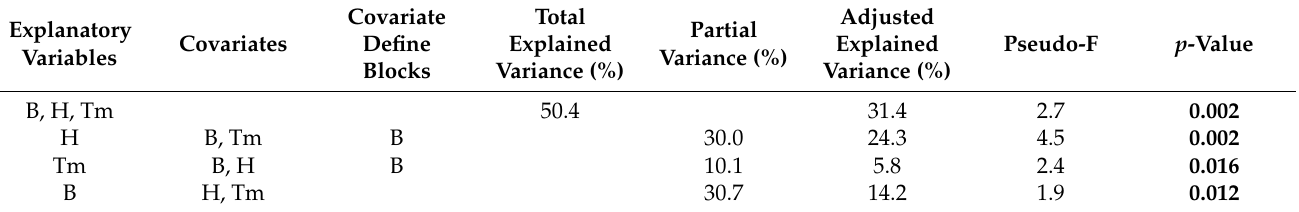
Table 5. Effect of site (B), habitat (H) and time (Tm) on variation of Collembola communities across coastal and intertidal habitats indicated by canonical correspondence analysis (CCA) and partial canonical correspondence analysis (pCCA).